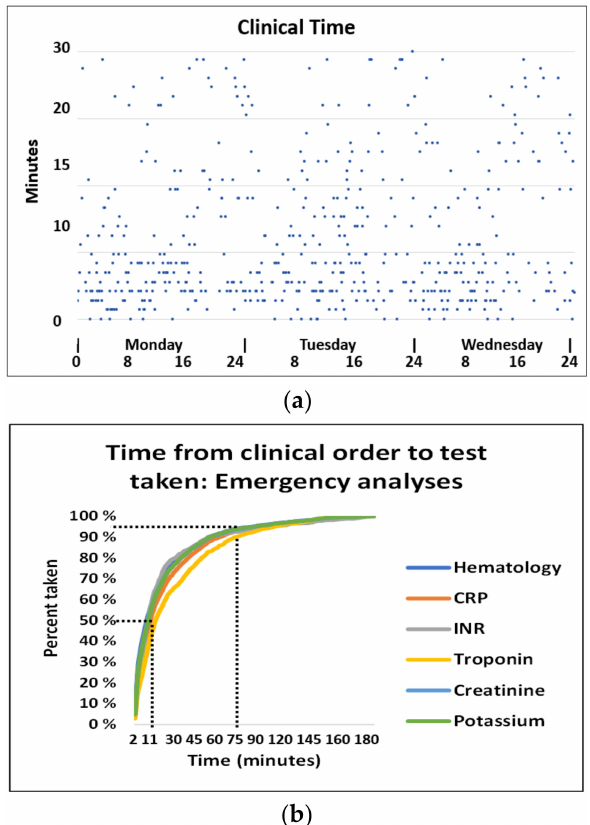
Figure 8. ( a ) Single time points. Diurnal measurements of clinical time. ( b ) Time from ordering to performing an emergency